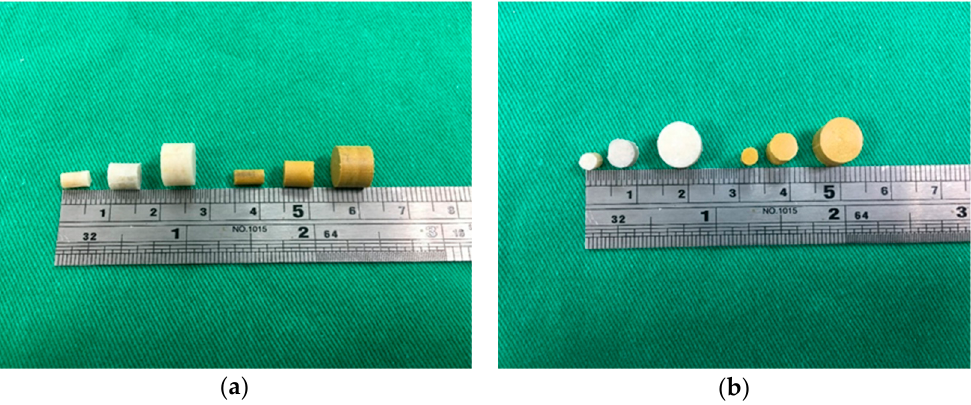
Figure 3. Photographs of the fabricated drug-loaded beads. The white cylindrical beads are fluconazole-impregnated Poly( D , L -lactide- co -glycolide) (PLGA) beads. The yellow cylindrical beads are amphotericin B-impregnated PLGA beads.